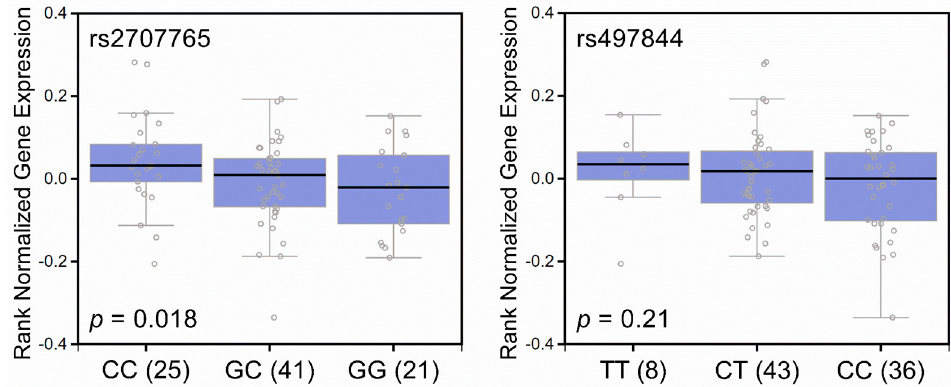
Figure 2. Correlation of rs2707765 and rs497844 genotypes and APC gene expression in prostate tissues. Boxplots represent APC mRNA expression according to the rs2707765 ( left panel) and rs497844 ( right panel) genotypes in 87 human prostate tissues (Genotype-Tissue Expression (GTEx) dataset). There is a trend toward increased APC mRNA expression in the prostate tissues of rs2707765 protective allele C carriers and rs497844 protective allele T carriers. The numbers in parentheses indicate the number of cases.